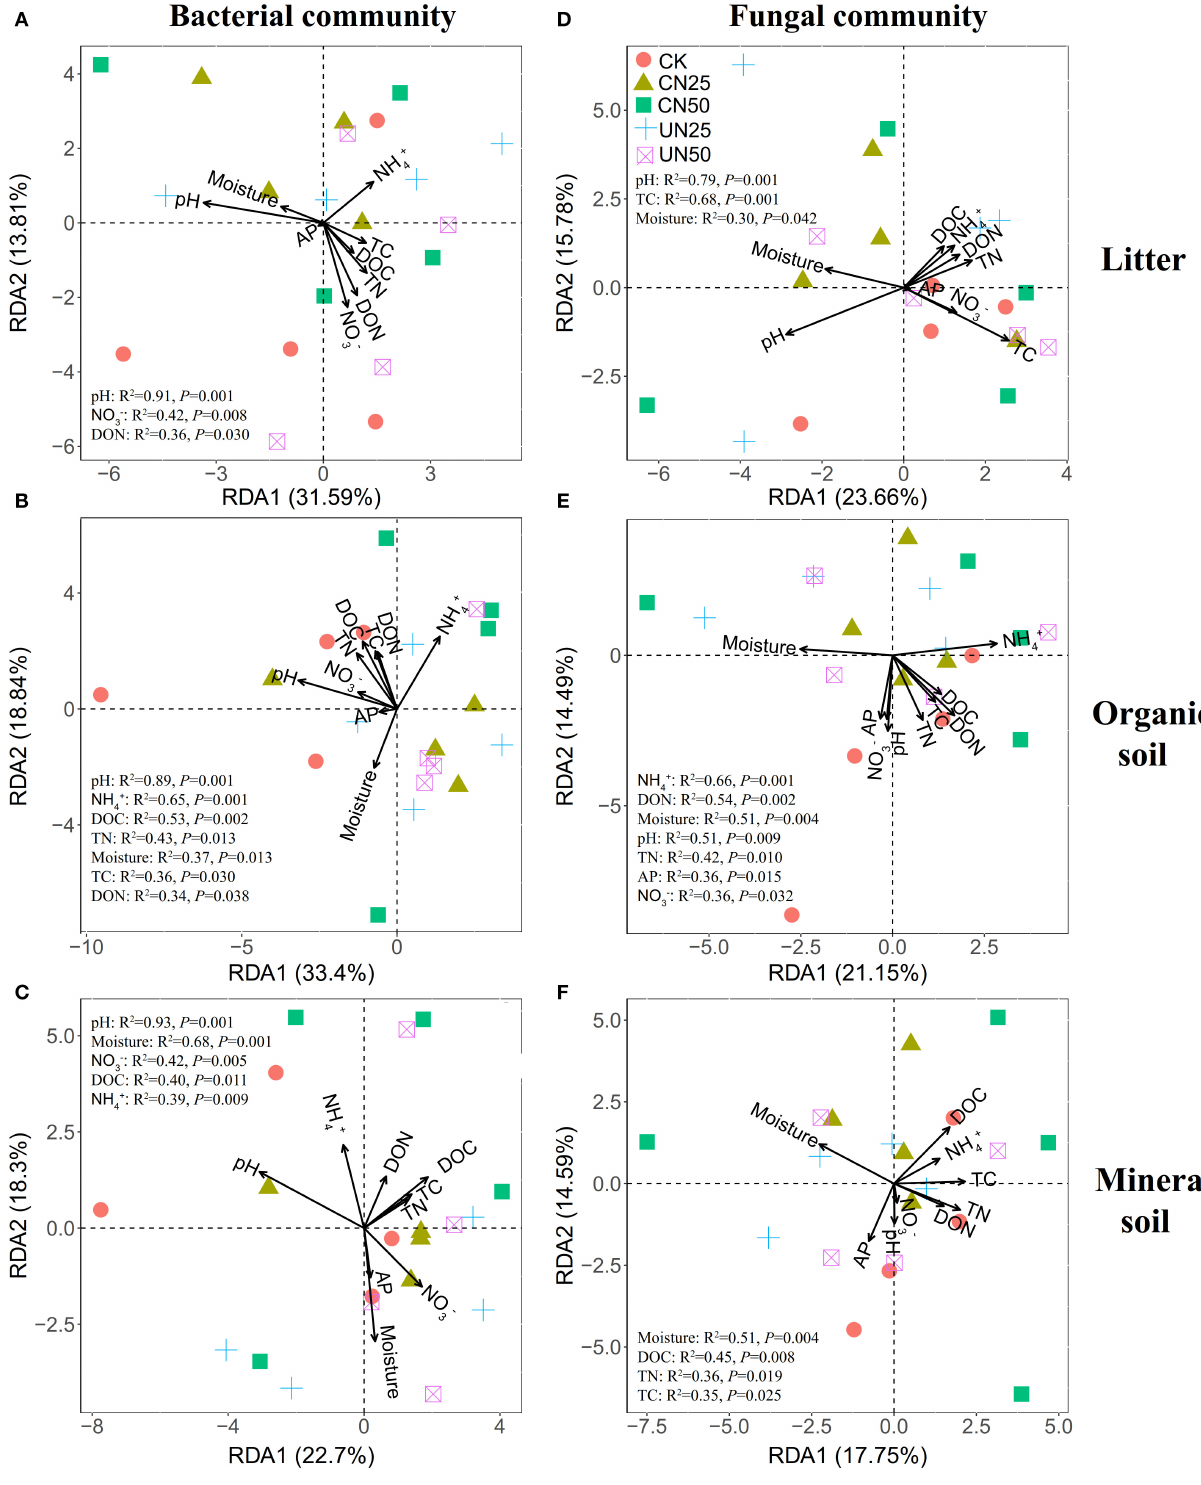
Frontiers in Microbiology |